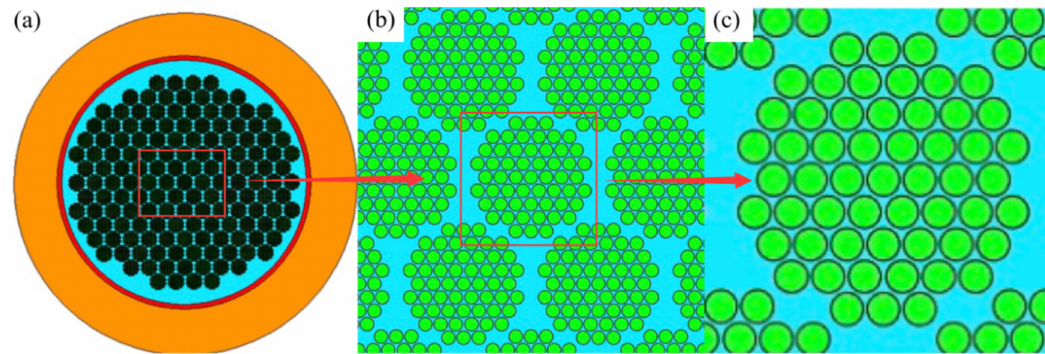
Figure 2. The hierarchical structure of the EAS-Nb 3 Sn strand: ( a ) EAS-Nb 3 Sn superconducting stranded wire, ( b ) Nb 3 Sn fiber bundles, ( c ) the Nb 3 Sn fibers reinforced in a bronze matrix.